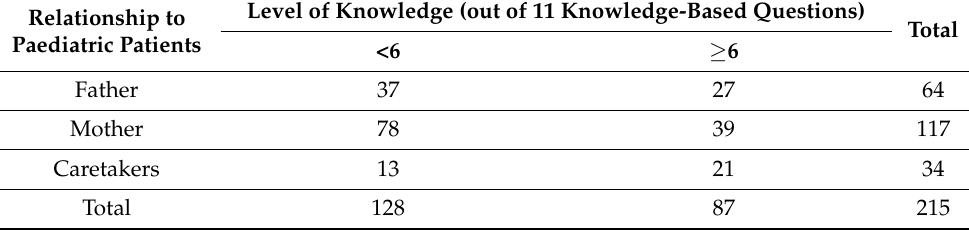
Table 4. The number of respondents who achieved satisfactory knowledge score and their relationship with the paediatric patients. There is a significant association between respondents’ roles and knowledge on the subject